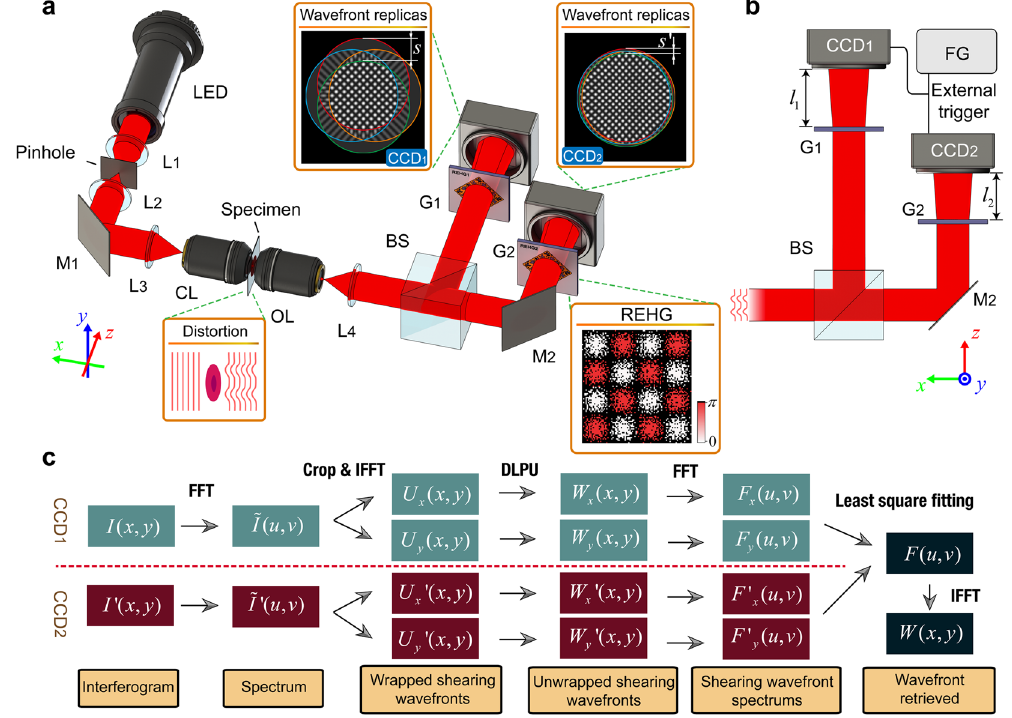
Figure 1. Principle of WSEIM and our phase retrieval algorithm. ( a ) Optical layout of WSEIM: L1, L2, L3 and L4, lenses; M1 and M2, mirrors; CL, condenser lens; OL, objective lens; BS, beam splitter; G1 and G2, REHGs. The light emitted from a LED chip is collimated by a collimator first and filtered by a pinhole to become a plane wave probe when it reaches the specimen. The variation of refractive index distribution in the specimen results in the wavefront distortion of the probe. Then the probe is divided into two beams and each of them is diffracted into four replicas by a REHG. Two quadriwave lateral shearing interferograms with different lateral shear s and s ′ are recorded by CCD1 and CCD2 simultaneously. ( b ) Schematics of the wideband-sensitivity- enhanced phase imaging system: FG, function generator. The difference in the lateral shears is controlled by altering the distances l 1 and l 2 from the REHGs to the CCD image plane. An external trigger signal provided by a function generator is employed to synchronize the image acquisition of two CCDs. ( c ) Schematic diagram of the phase retrieval algorithm for WSEIM. The first three steps are similar with the phase retrieval in the DHM, but the wavefronts obtained with these steps are just the shearing wavefronts. The differential leveling phase unwrapping (DLPU) algorithm is proposed to unwrap the shearing wavefronts. And the wavefront under test will finally be retrieved from its Fourier spectrum, which can be obtained from the four spectrums of shearing wavefronts using least-square fitting